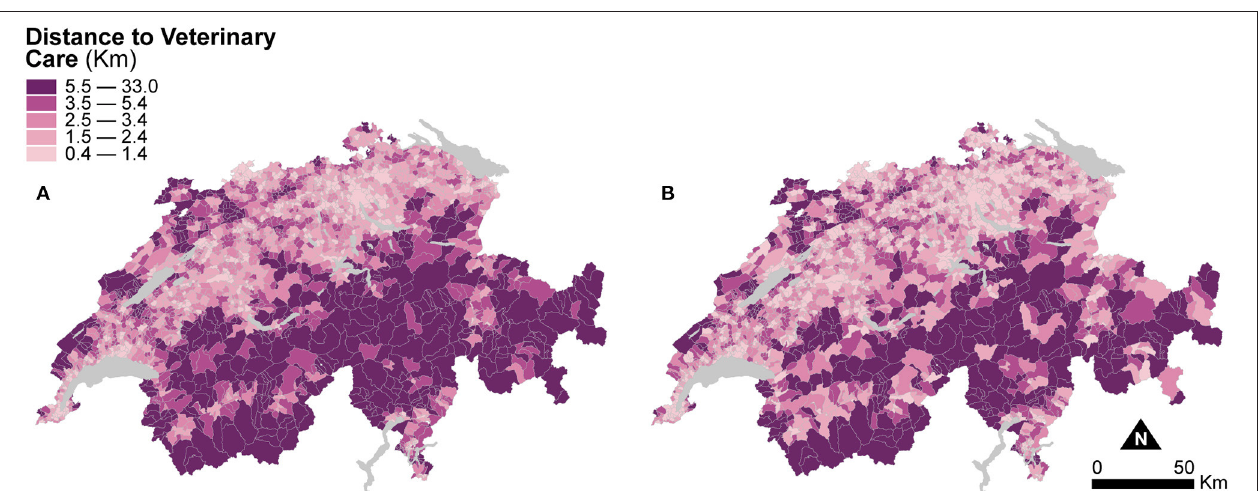
FIGURE 3 | Human population density indicators resulting from the two enumeration types — (A) municipal units and (B) dasymetrically refined units. For better visual comparison, the indicator recomputed after dasymetric refinement is also presented in a choropleth fashion. The data is classified according to the quantile classification method applied to the dasymetrically refined units.